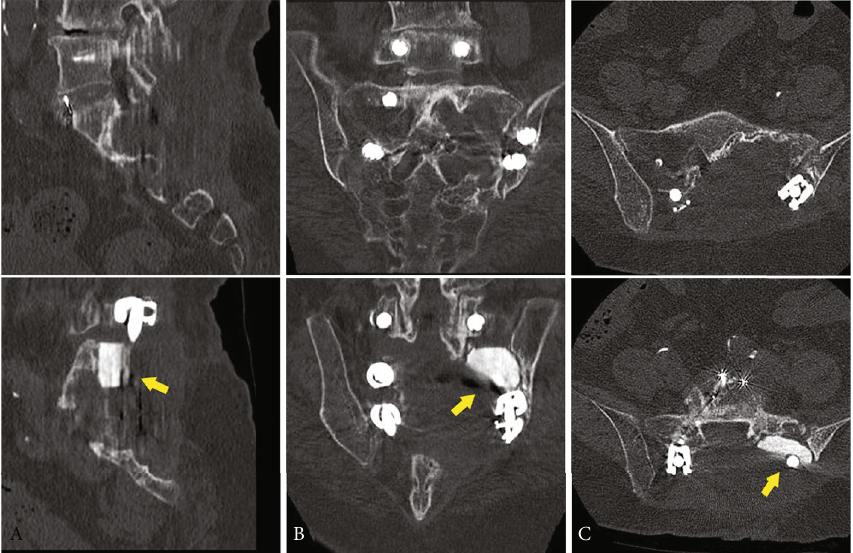
Figure 3: As of 10 months after the surgery, computed tomography shows no recurrence of the tumor and no dislocation of the implants including the β -tricalcium phosphate (yellow arrows): (A) sagittal; (B) coronal; (C) axial.